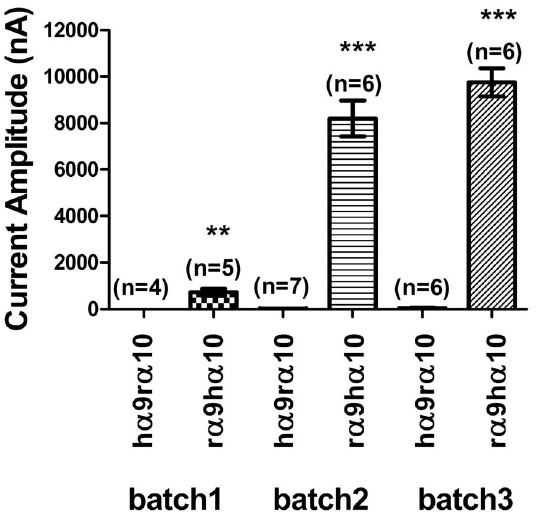
Figure 2. Comparison between the level of expression of human a 9/rat a 10 (h a 9r a 10) and rat a 9/human a 10 (r a 9h a 10) receptors. Receptors assembled from injection of cRNAs encoding subunits from different species have different levels of functional expression. h a 9r a 10 nAChRs were expressed with low efficiency compared to r a 9h a 10. Results from three batches of oocytes are shown. All oocytes of a given batch were injected on the same day and recordings performed 2 days later. Values of mean current amplitudes are given in Table 1. **p , 0.01. Error bars indicate SEM.